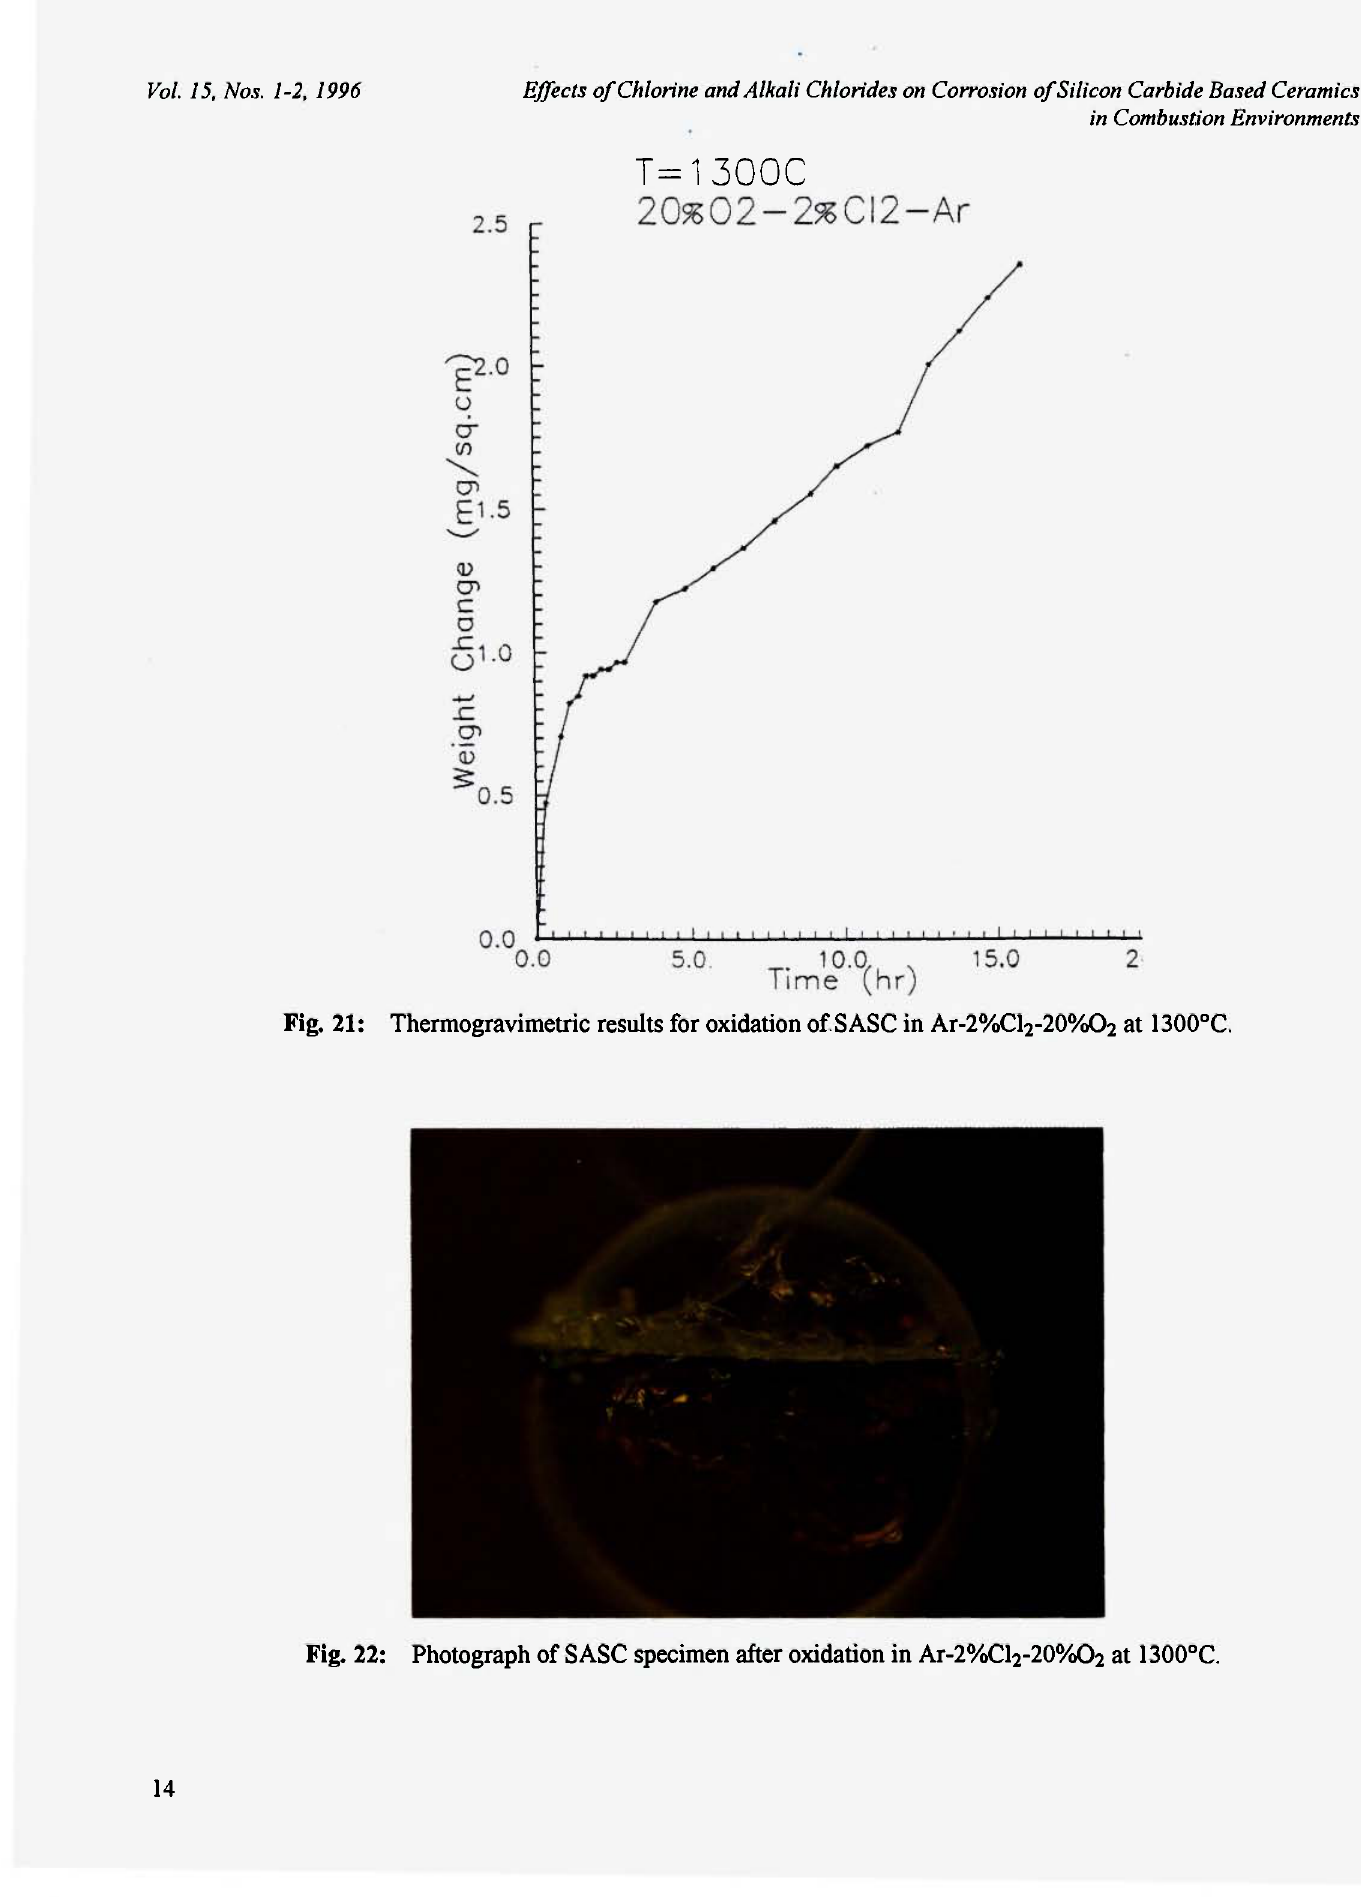
Fig. 22: Photograph of SASC specimen after oxidation in Ar-2%C1